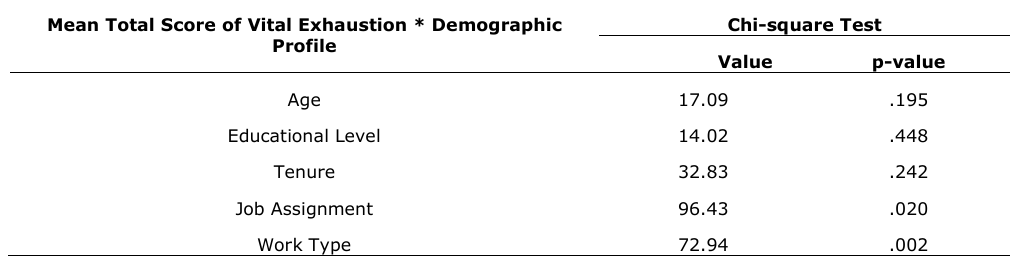
Table 6. Coefficients (p-values) of Chi-square tests between vital exhaustion and socio-demographic profile of off-shore personnel